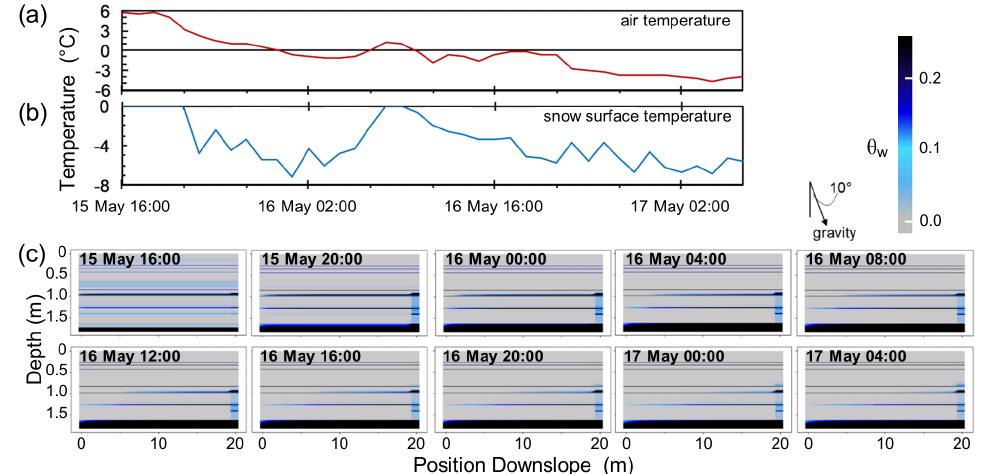
Figure 6. Time series results of SnowTOUGH simulations for the above-treeline (AT) site showing (a) measured air temperature, (b) simu- lated snow surface temperature, and (c) volumetric liquid water content ( θ w ) distribution at 4h